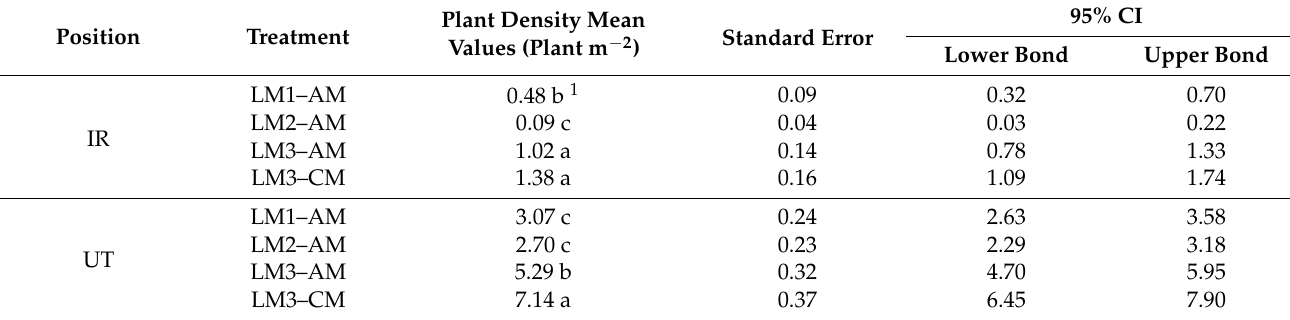
Table 2. Results of pairwise comparisons for Erigeron canadensis plant density in function of treatments (LM1–AM, LM2–AM, LM3–AM, LM3–CM) and positions (IR and UT). LM1–AM: living mulch 1 autonomously mowed; LM2–AM: living mulch 2 autonomously mowed; LM3–AM: living mulch 3 autonomously mowed; LM3–CM: living mulch 3 conventionally managed. IR: inter-rows, UT: Under vineyards trellis. Mean separations have been carried out separately for positions.